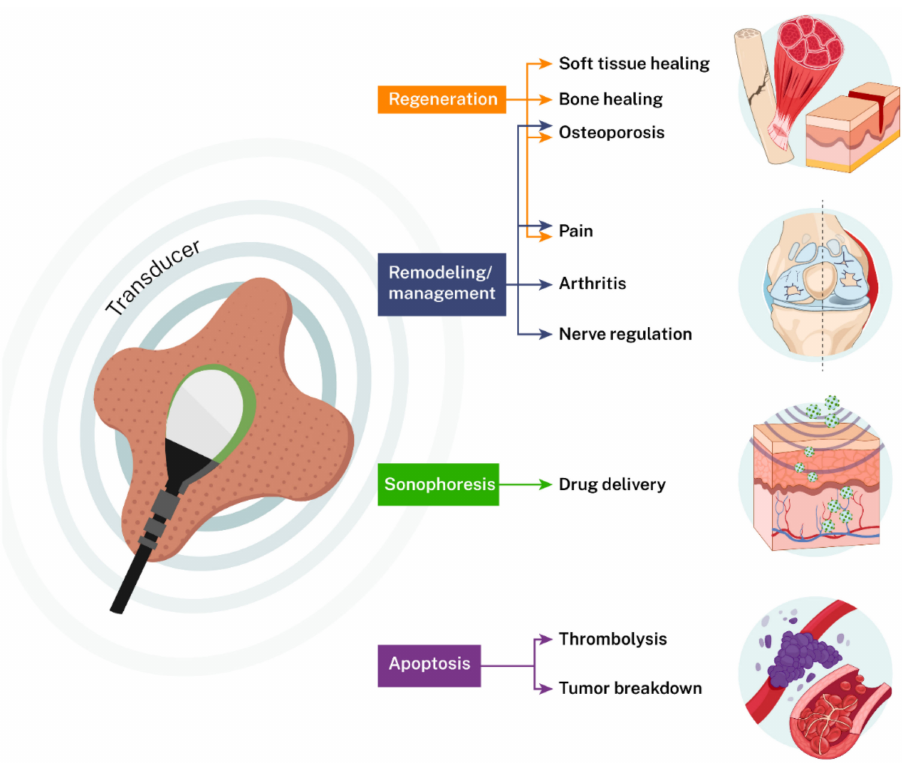
Figure 2. Applications of LICUS in medicine. LICUS can be used to regenerate soft and hard tissues, pain management, sonophoresis, thrombosis, and